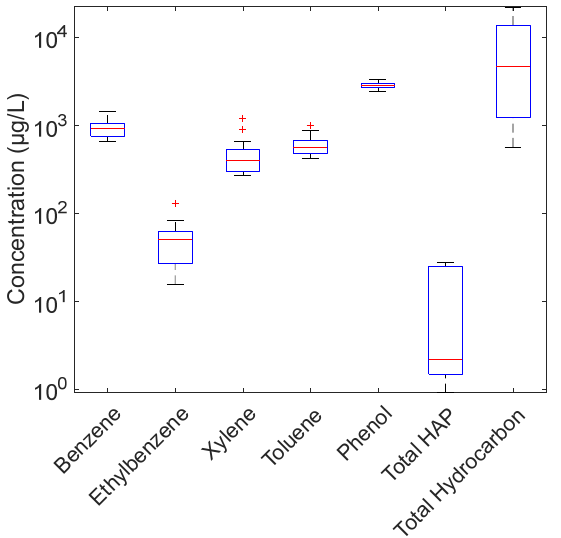
Figure 3. Produced water composition_Total and dissolved hydrocarbon concentrations.